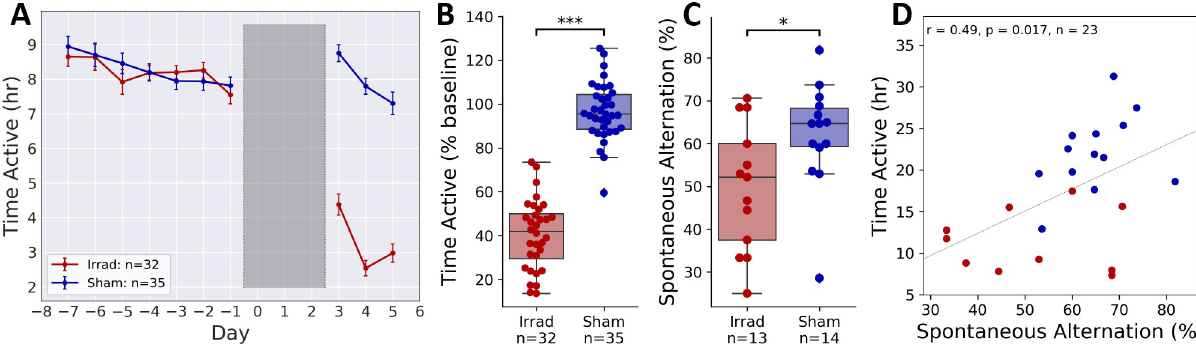
Fig 2. Arena tests. (A) Mean daily VWRA totals. Grey shaded area indicates days of irradiation. (B) VWRA across the 3-day post-irradiation period normalized to the individual 7-day baseline daily means. (C) Spontaneous alternation rate in the Y-maze test. (D) Correlation between VWRA and spontaneous alternation in the Y-maze. � p < 0.05, ��� p < 0.0005.